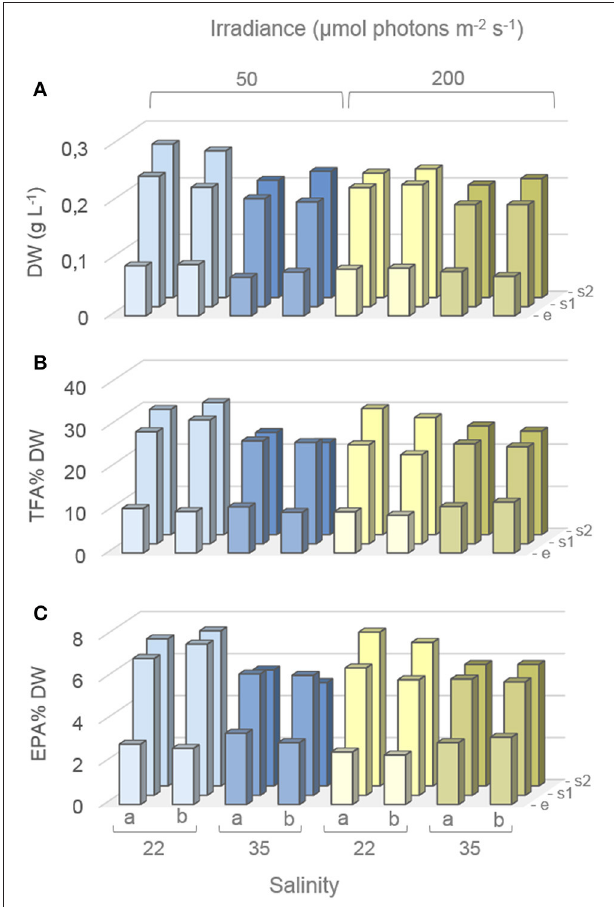
FIGURE 3 | Dry weights (DW) and fatty acid content during factorial-design batch experiment. Average DW (A) , and total fatty acid (TFA) and EPA contents ( B,C respectively) of Attheya septentrionalis cultures at 12 different treatments (two biological replicates per treatment, a and b). Values are average of three measurement replicates. Detailed values with standard deviations can be found in Table S2. e, exponential phase; s1, first stationary phase (Day3); s2, second stationary phase (Day